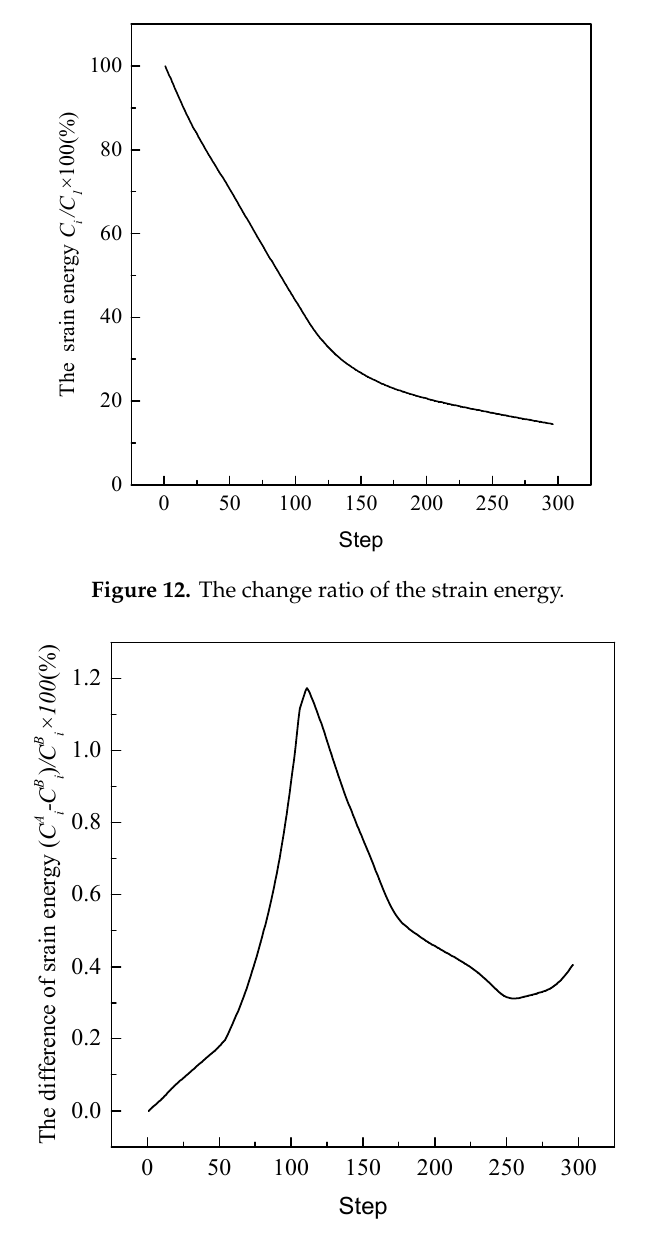
Figure 13. The di ff erence of the strain energy between Schemes A and B at the same Figure 13. The difference of the strain energy between Scheme A and B at the same step.